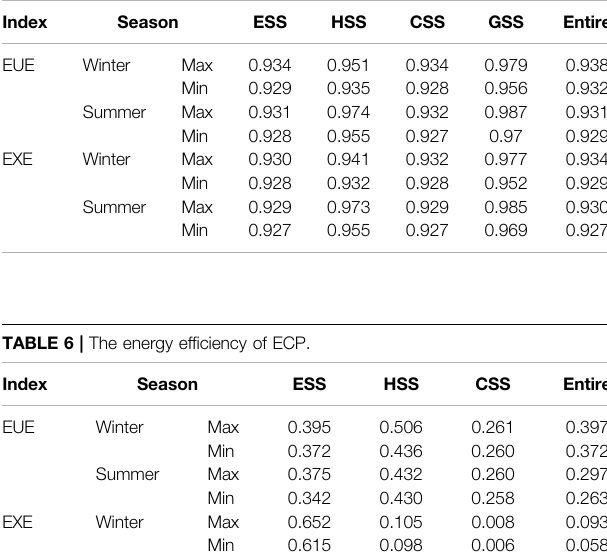
TABLE 5 | The energy ef fi ciency of ETP.